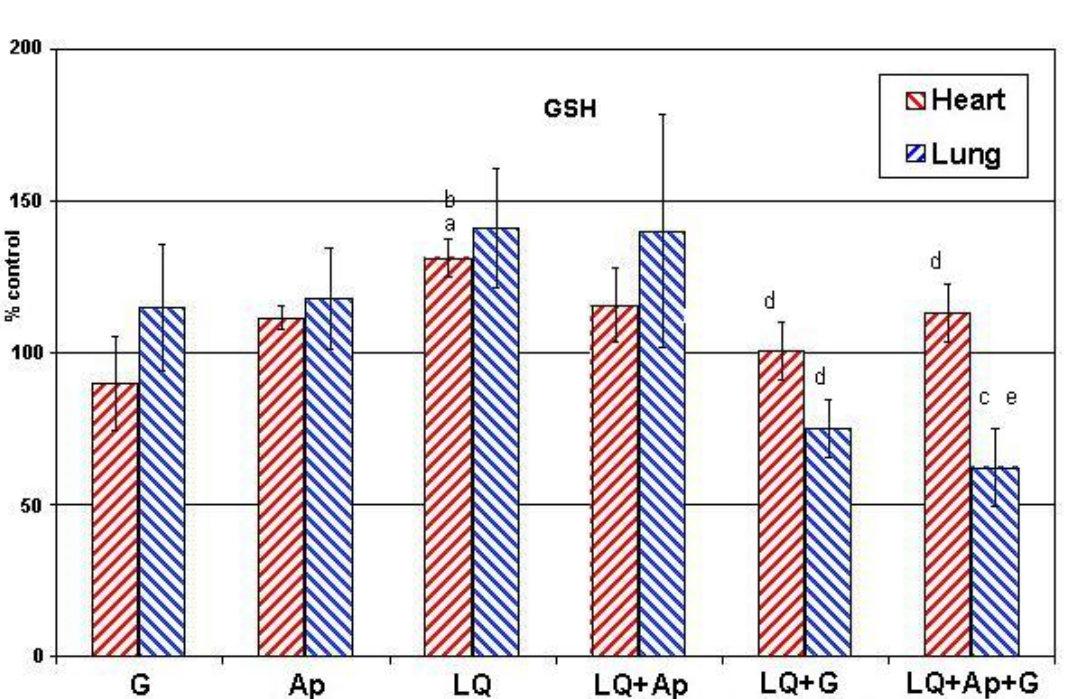
Figure 1: Effects of Leiurus quinquestriatus venom (LQ) alone or after pretreatment with Ginkgo biloba extract (G) and/or aprotinin (Ap) on glutathione levels (GSH) in rat heart and lung